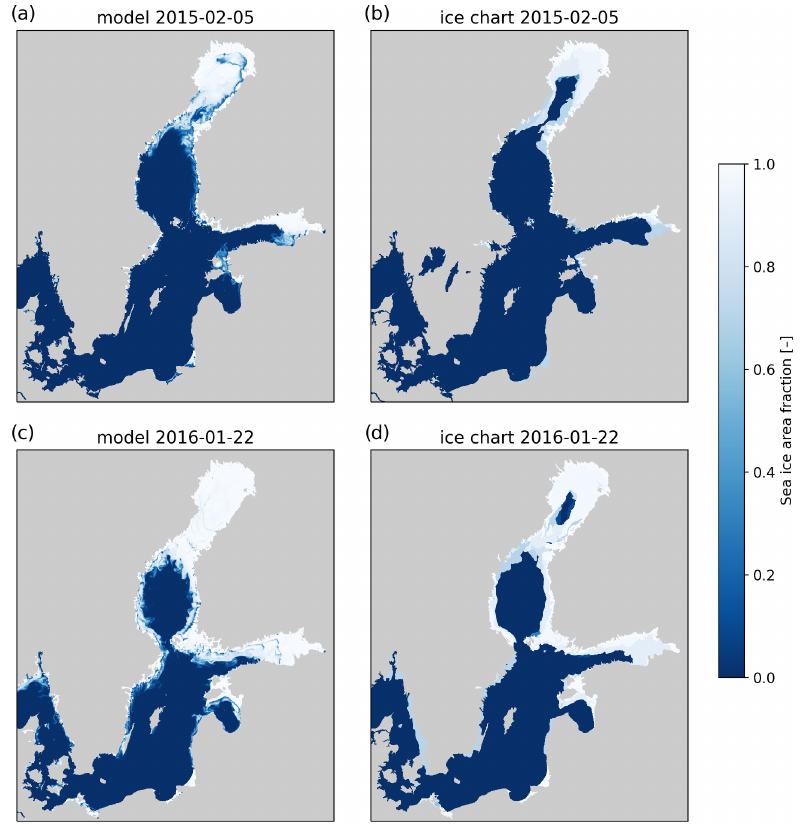
Figure 12. Comparison of sea ice area fraction from the model (a, c) and ice charts (b, d) for the maximal sea ice extent conditions in 2015 and